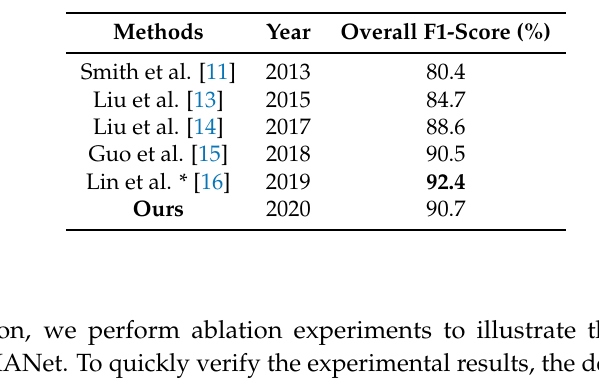
Table 2. Results on the Helen test dataset. * Denotes additional data